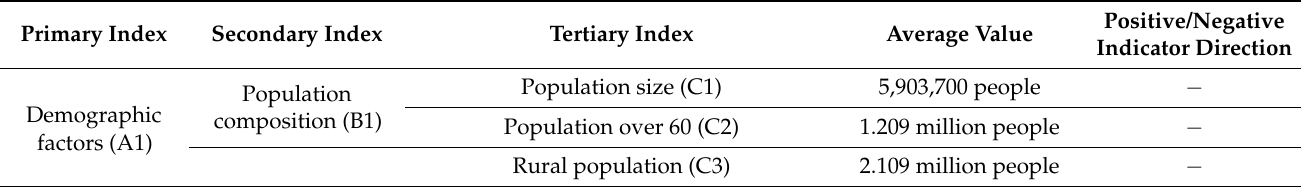
Table 1. The evaluation system for the sustainable and coordinated development of urban and rural medical